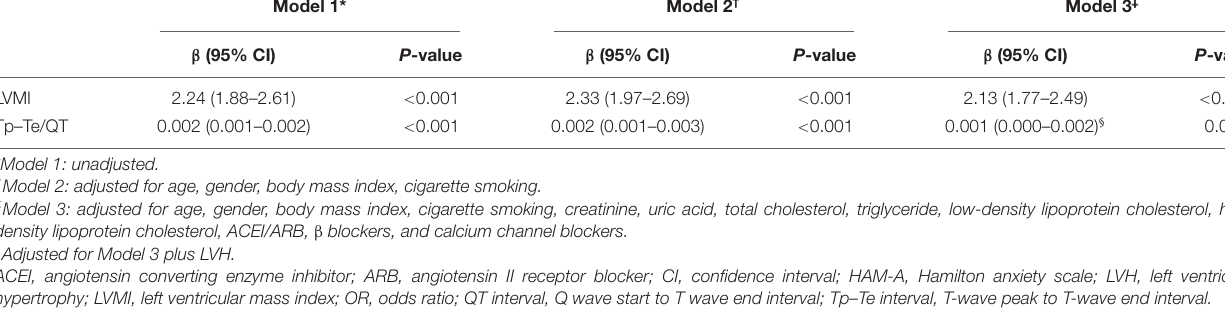
FIGURE 1 | The left ventricular mass index (LVMI) and Tp–Te/QT ratio of hypertensive patients and correlation with Hamilton anxiety scale (HAM-A) score. (A) The LVMI was significantly higher in hypertensive patients with anxiety than hypertensive patients without anxiety ( p < 0.001). (B) The HAM-A score was significantly positive correlated with LVMI ( r = 0.578, p < 0.001). (C) The Tp–Te/QT ratio was significantly higher in hypertensive patients with anxiety than hypertensive patients without anxiety ( p < 0.001). (D) HAM-A score was weakly positively correlated with Tp–Te/QT ratio in hypertensive patients ( r = 0.252, p < 0.001). HAM-A, Hamilton anxiety scale; LVMI, left ventricular mass index; QT interval, Q wave start to T wave end interval; Tp–Te interval, T-wave peak to T-wave end interval. TABLE 2 | Linear regression associations of HAM-A score with LVMI and Tp–Te/QT ratio. Model